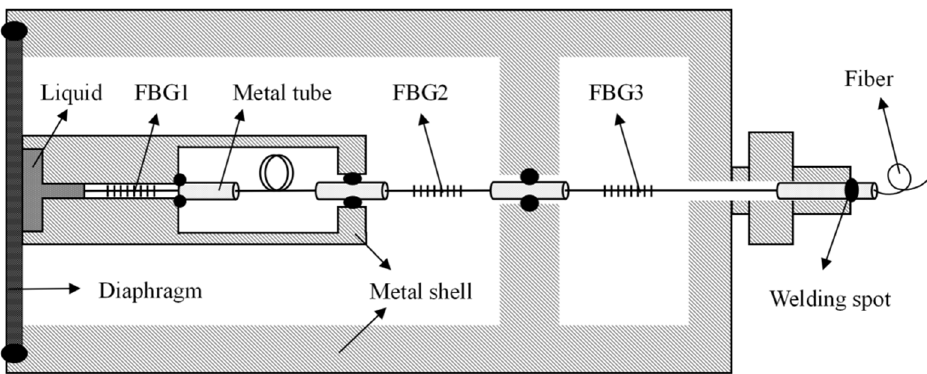
Figure 1. Schematic diagram of temperature- and depth-sensing structure